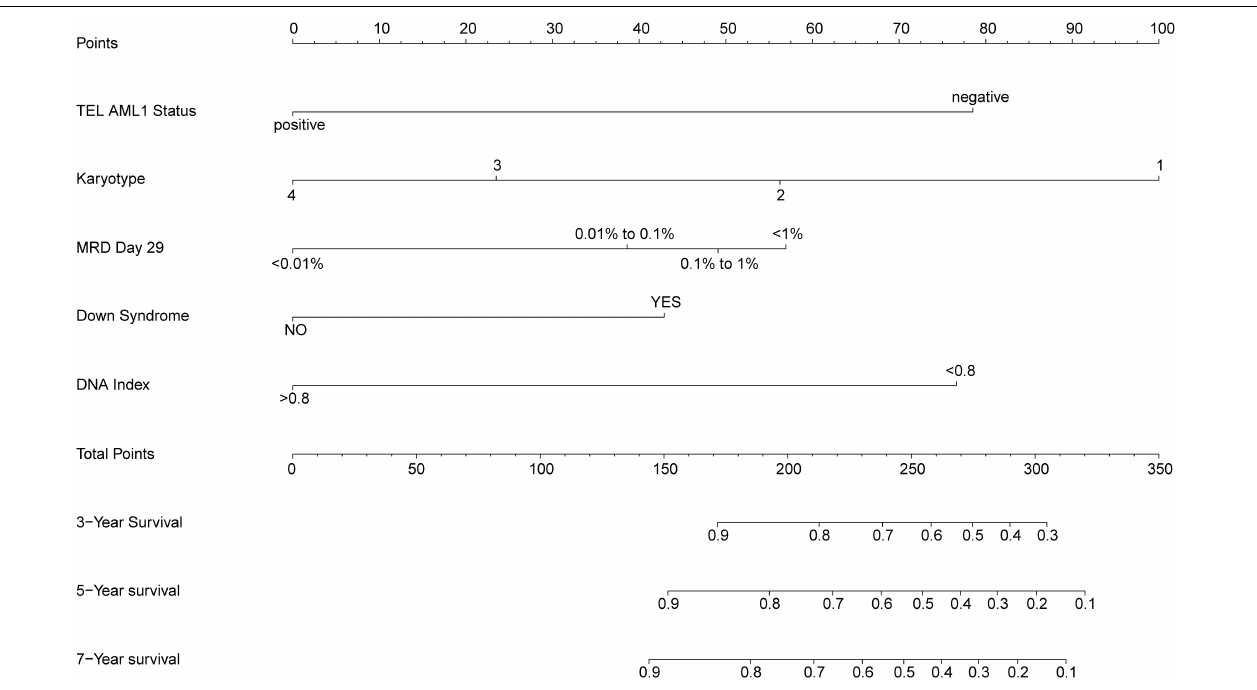
FIGURE 2 | Prognostic nomogram for overall survival (OS). Childhood acute lymphoblastic leukemia survival nomogram. To use the nomogram, an individual patient’s value is located on each variable axis, and a line is drawn upward to determine the number of points received for each variable value. The sum of these numbers is located on the total points axis, and a line is drawn downward to the survival axes to determine the likelihood of 3-, 5-, and 7-year survival. CNS status, central nervous system status at diagnosis; MRD day 29, minimal residual disease status at day 29 of induction therapy; NA, no trisomies in 4, 10, 17, 18; T1, 4, 10, 17, and 18 have only one trisomy; DT, double trisomies; TT, triple trisomies.